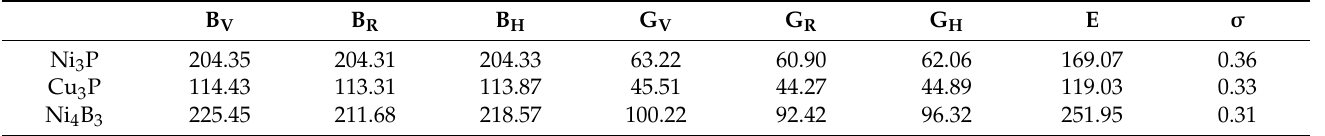
Table 4. Ni 4 B 3 related modulus data sheet Unit: